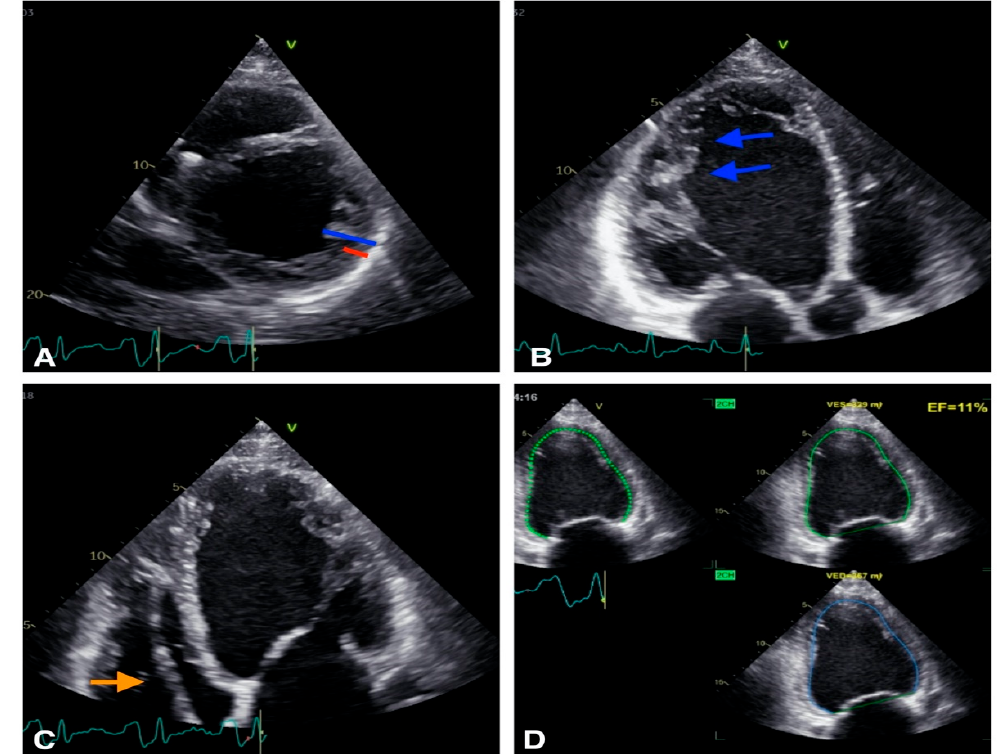
Figure 2. Example of a patient with non ‐ compaction cardiomiopathy. ( A ): 2D short axis view, the non compaction myocardium (blue) is twice thicker than the compacted myocardium (red). ( B ): 2D apical 3 chambers view, trabeculations are visible (blue arrows). ( C ): 2D apical 4 chambers view: defibrillator lead is visibile in right ventricle (orange arrow). ( D ): Biplane EF is calculated at 11% showing severe LV systolic dysfunction.